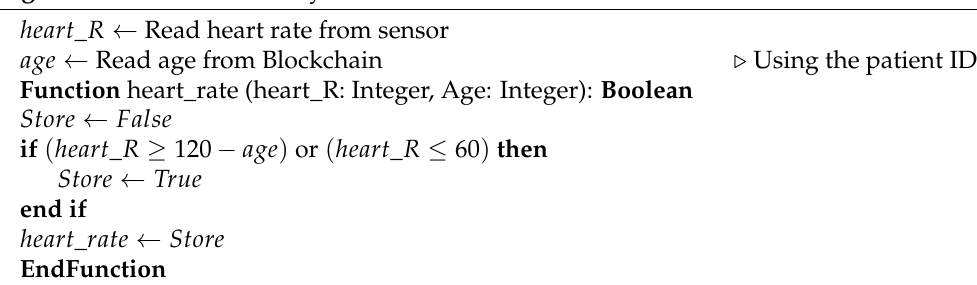
Algorithm 1 Heart rate